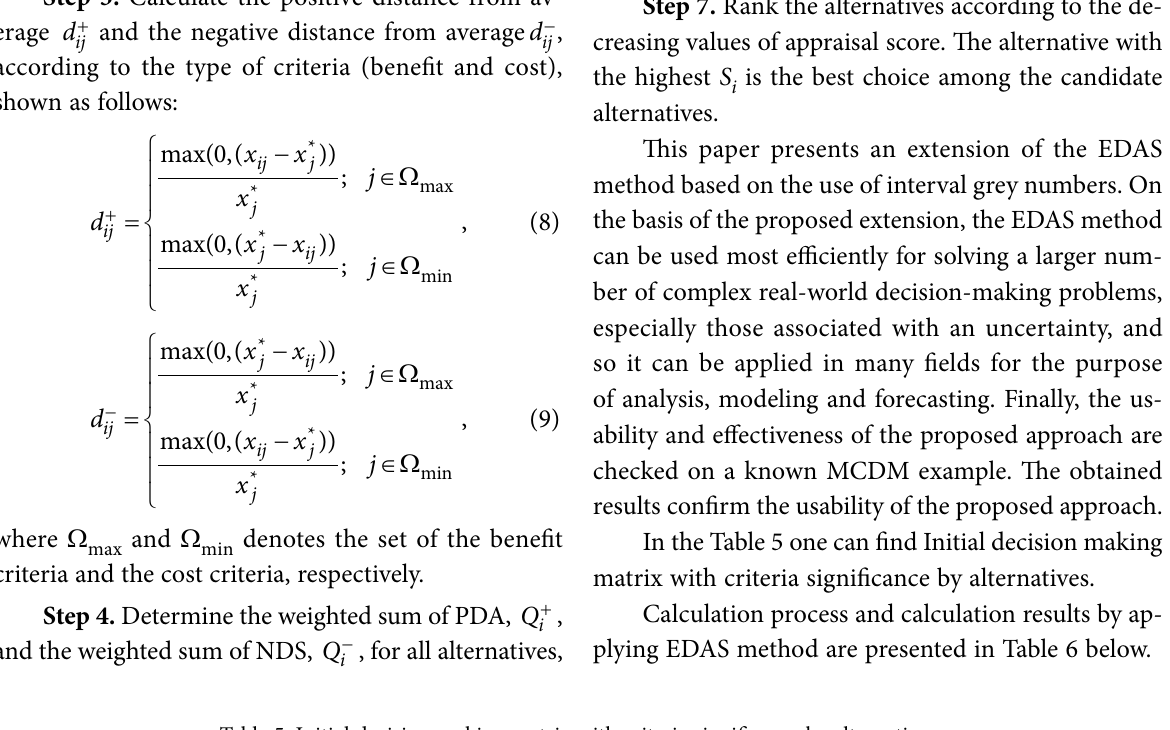
Table 5. Initial decision making matrix with criteria significance by